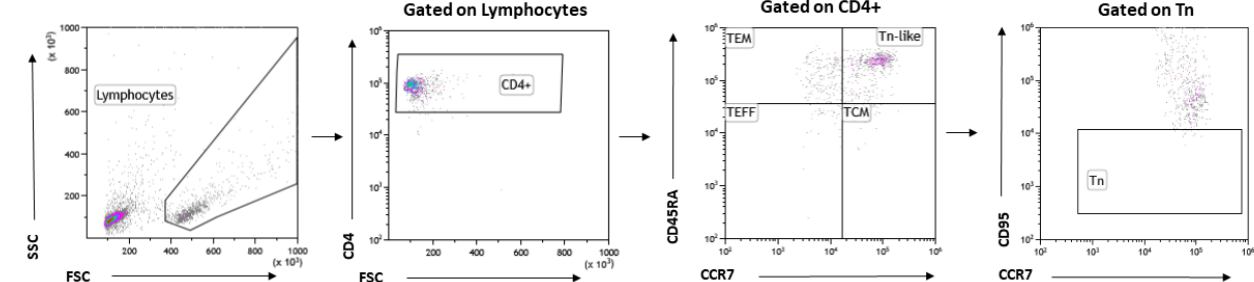
Figure 1. Gating strategy for T cell phenotyping. Subsets were gated based on CCR7 and CD45RA expression. In the next step Tn-like cells were differentiated by gating and the percentage of stem cell like memory cells was calculated. TEM: effector T memory cells, TEFF: T effector cells, TCM: central T memory cells, Tn: naive T cells, SSC: side scatter, FSC: Forward sideward